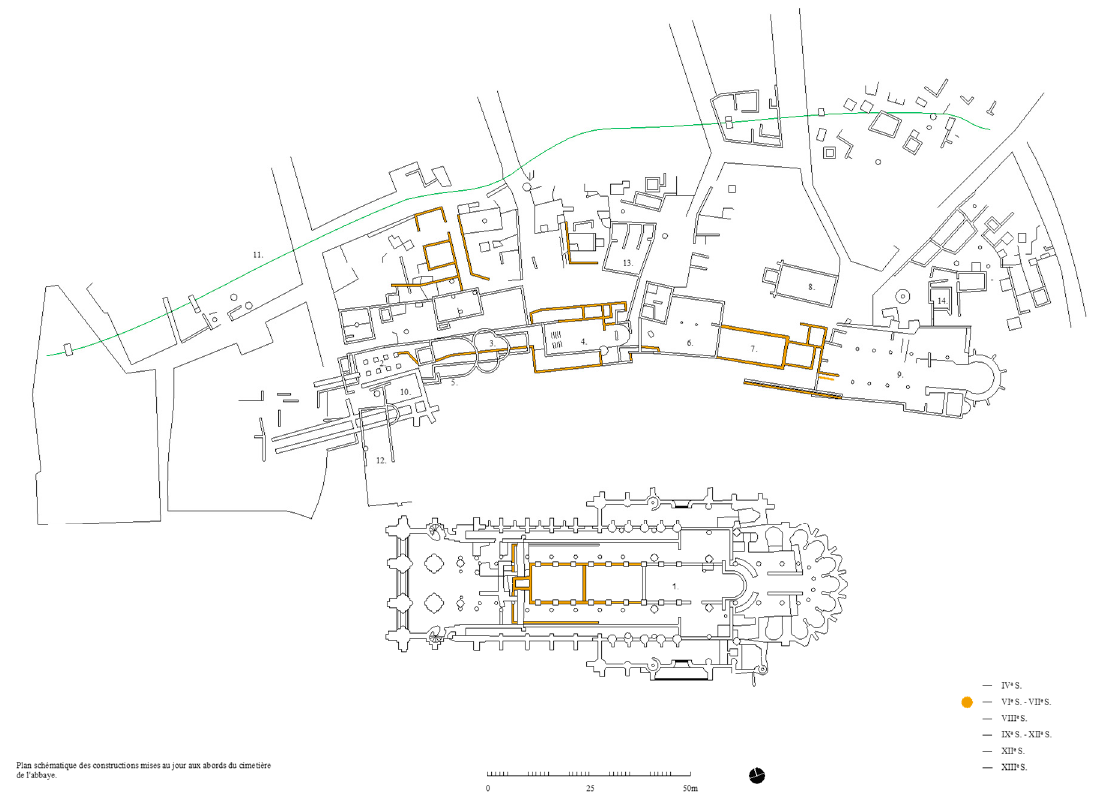
Figure 1. Phase of construction of the Abbey of Saint-Denis according to the archaeological research of Michaël Wyss: 1. Abbey Church. 2. Sainte-Geneviève Church. 3. Saint-Michel-du-Degré Church. 4.